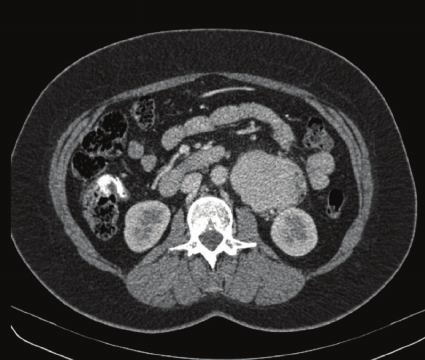
Figure 1: Preoperative abdominal computed tomography (CT) scan depicting a voluminous left pararenal